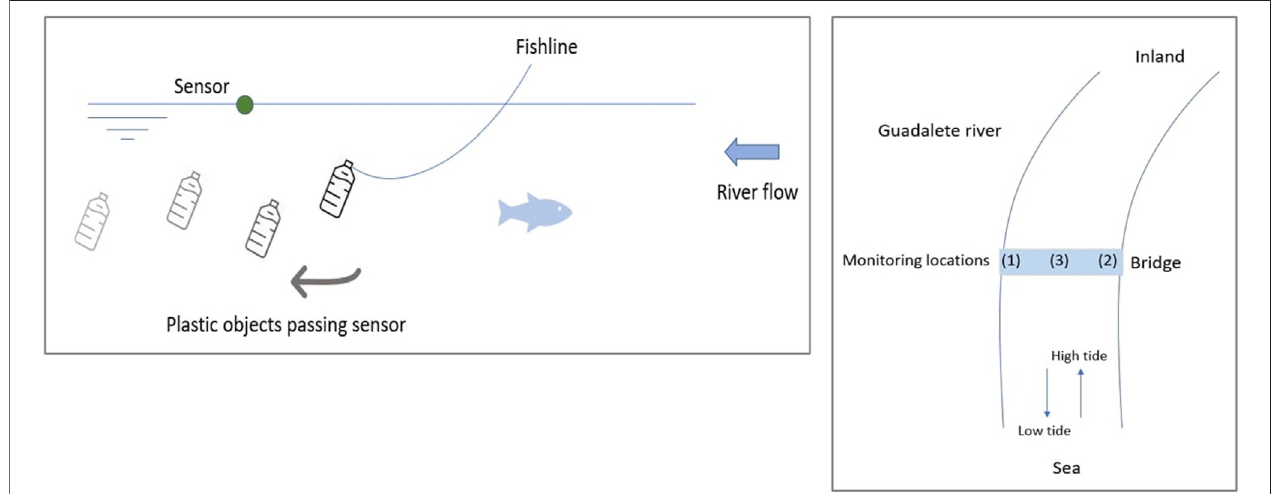
FIGURE4| Experimentalset-upsforthesemi-anduncontrolledtests.Set-up1(Left),appliedintheRiodeSanPedro,passingplasticitemsunderneaththesensor. Set-up 2 (Right), the three monitoring locations over the cross-section of the Rio de Guadalete. Monitoring was performed for 11 sets at location 1, 2 sets at location 2 and 5 sets at location